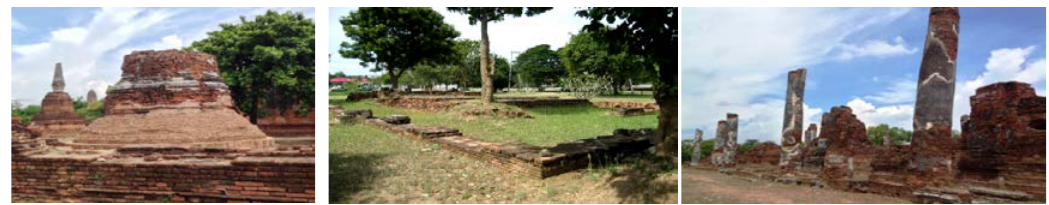
Figure 5. Cultural Heritage assets in Ayutthaya, Thailand.